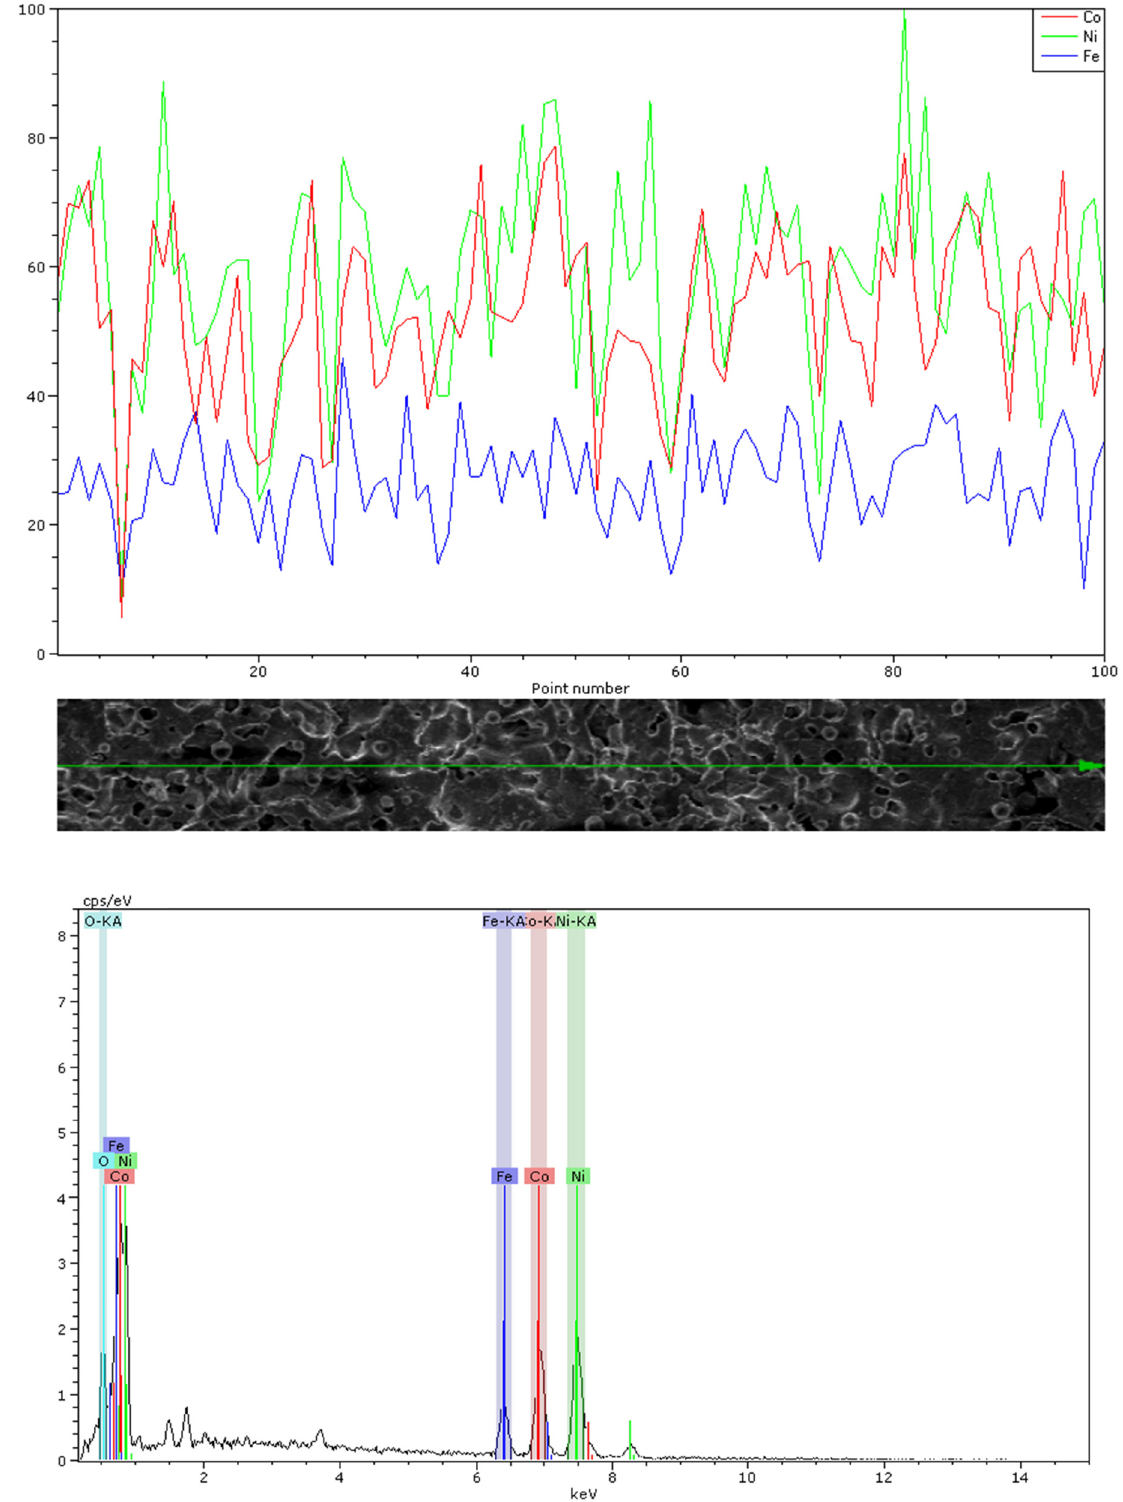
Figure 11: EDX - Analysis of the ( Fe – 20% Co ) 60% Ni specimen at